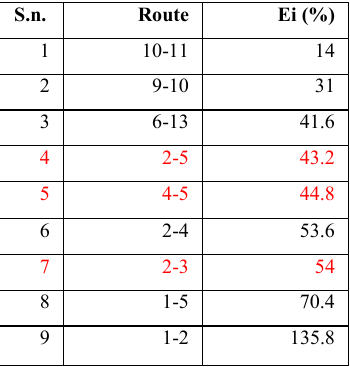
TABLE 5. BUS DATA OF DEHRADUN SYSTEM IN